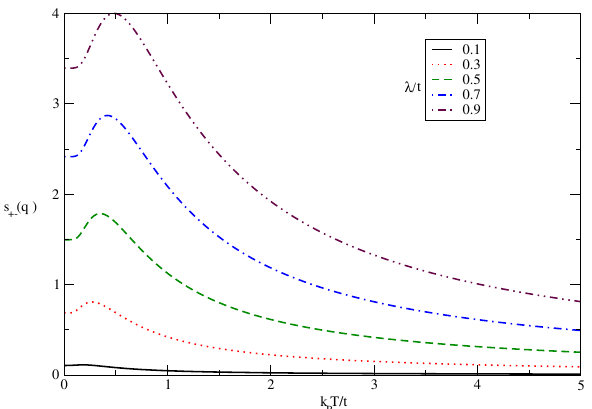
( q 0 , T ) of undoped Germanene layer versus +−